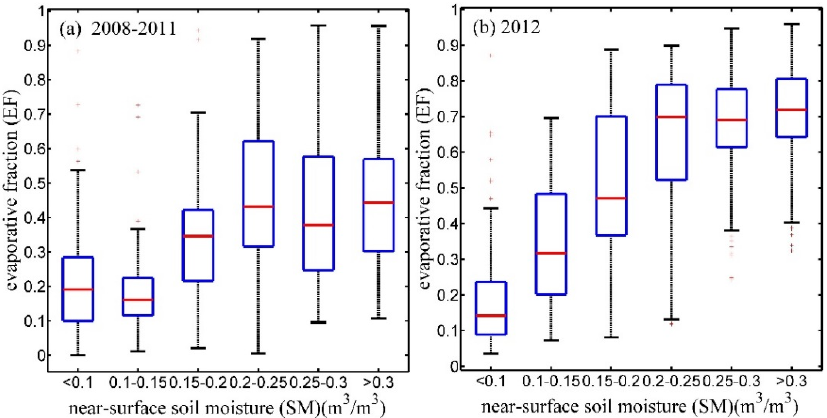
Figure 2. Box and whisker plots of near-surface soil moisture (SM) and evaporative fraction (EF) at ( a ) the Yingke station during the WATER experiment (2008–2011) and ( b ) sixteen stations of the HiWATER experiment (2012). SM denotes the daily average values of soil moisture measurements at a 5 cm depth, and EF is the evaporative fraction of the clear-sky daytime averages of the EC